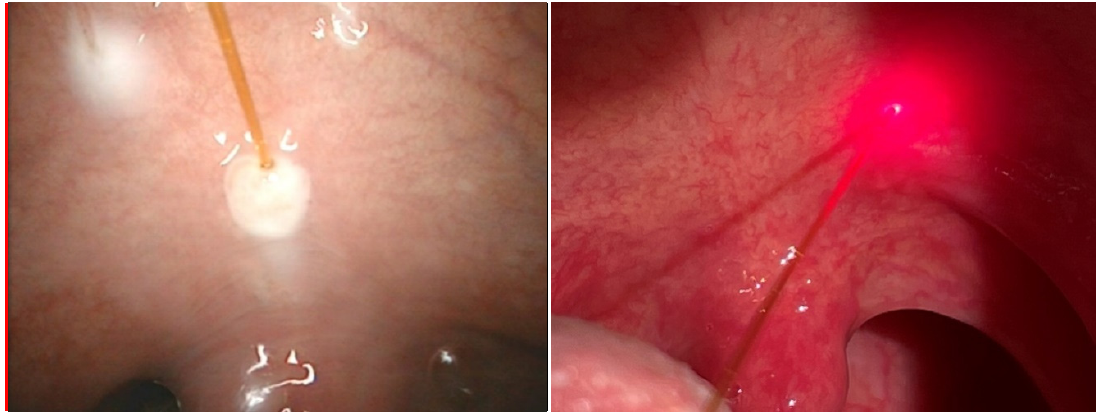
Figure 1. Introduction of laser fiber into a soft palate.